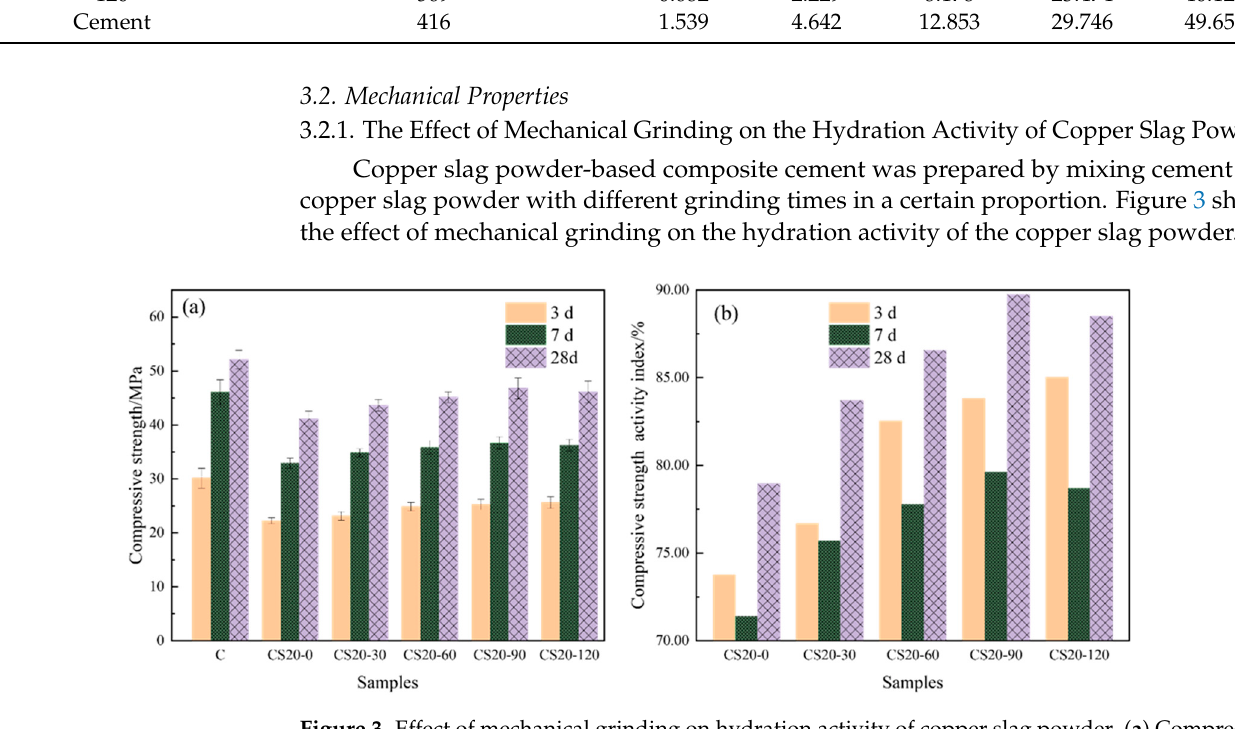
Figure 3. Effect of mechanical grinding on hydration activity of copper slag powder. ( a ) Compressive strength; ( b ) compressive strength activity index.